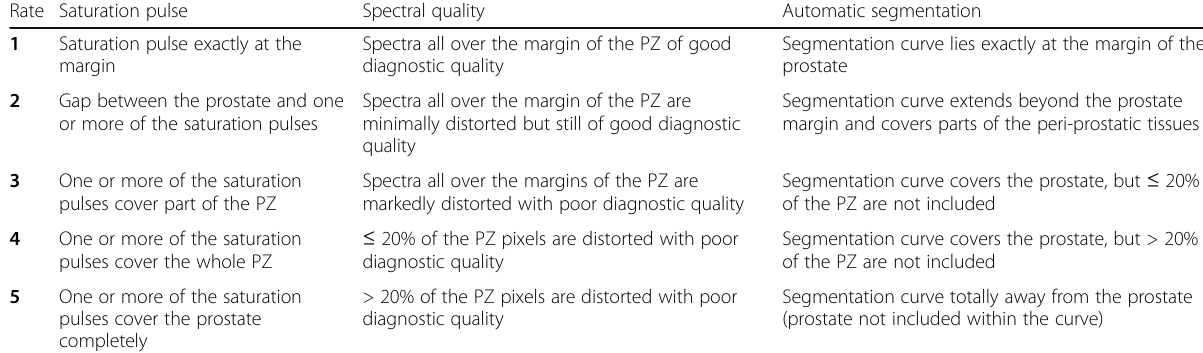
Table 2 5-point Likert scale evaluation of MRS